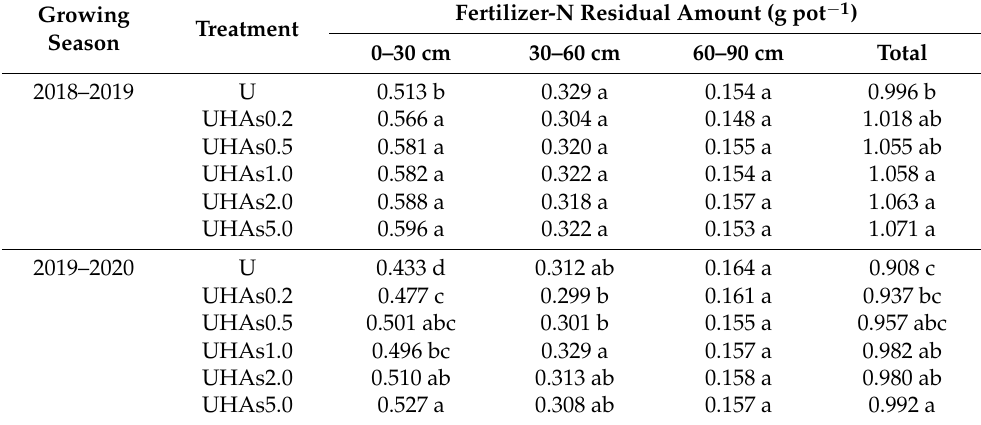
Table 4. Residual fertilizer-N after winter harvest under different proportions of HAs in urea fertilizer